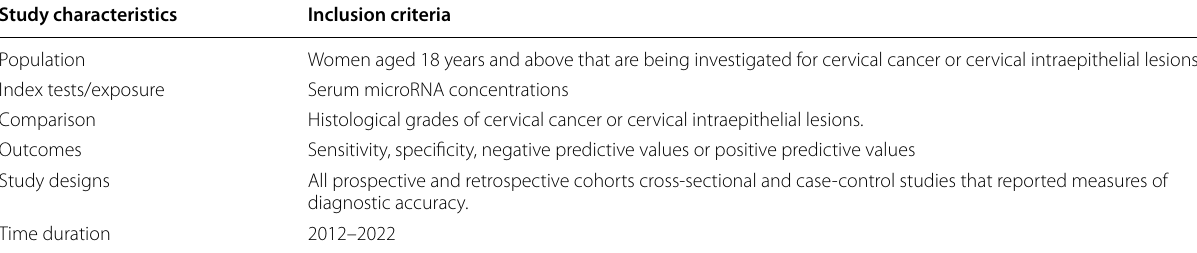
Table 1 Inclusion